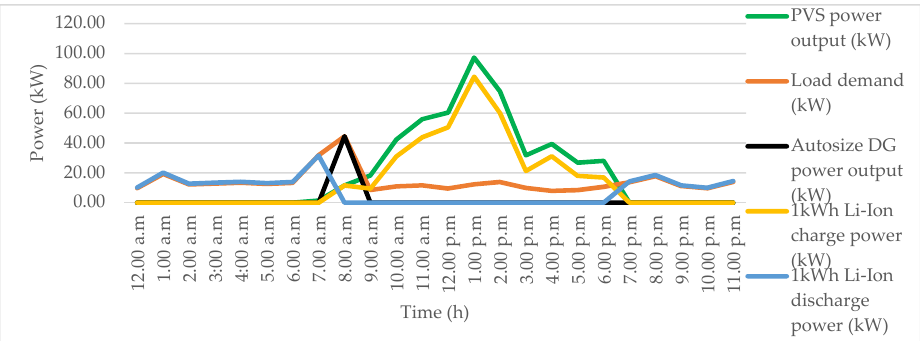
Figure 12. Daily time-stamped analysis for the month of October. In Figure 13, the daily time-stamped analysis for the month of June using a solar DG source with TSVA tracking technique is shown. The hourly data for PVS output power, autosize DG power output, 1 kWh Li-Ion charge power, 1 kWh Li-Ion discharge power and load demand are recorded on 20 June. The month of June is the summer for Kalpeni Island and as such the 25 households used air conditioners more, while the use of the water geyser reduces significantly. From 10.00 p.m. to 11.00 p.m. and 12.00 a.m. to 2.00 a.m., the air conditioner is used so that the load demand is more between this period as shown in Figure 13. Due to insufficient solar radiation between 12.00 a.m. and 6.00 a.m., the Li-Ion battery discharges power from 12.00 a.m. to 2.00 a.m. and 4.00 a.m. to 6.00 a.m. and the diesel generator generated 51.21kW power at 3.00 a.m. to satisfy the load demand. Between 7.00 a.m. and 8.00 a.m., PVS produces output between 9.08 kW and 27.40 kW and diesel generator produces 85 kW power output. The Li-ion battery is charged from the output of solar PVS and diesel generator during this period. Between 9:00 a.m. and 7:00 p.m., only the solar PVS is operated to satisfy the load demand while the diesel generator is not operated to avoid emission. The Li-Ion battery gets charged from 7.00 a.m. to 2.00 p.m. Finally, from 8.00 p.m. to 11.00 p.m., the Li-Ion battery discharges power. The discharging power is overlapping with the load demand from 12.00 a.m. to 2.00 a.m. and from 8.00 p.m. to 11.00 p.m.